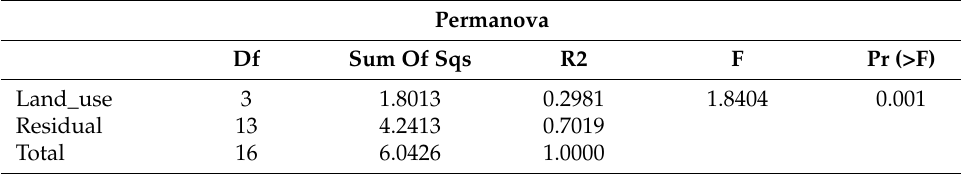
Table 5. The permutational multivariate analysis of variance results (PERMANOVA) (with 999 of permutations). Permanova Df Sum Of Sqs R2 F Pr (>F) 3 1.8013 0.2981 1.8404